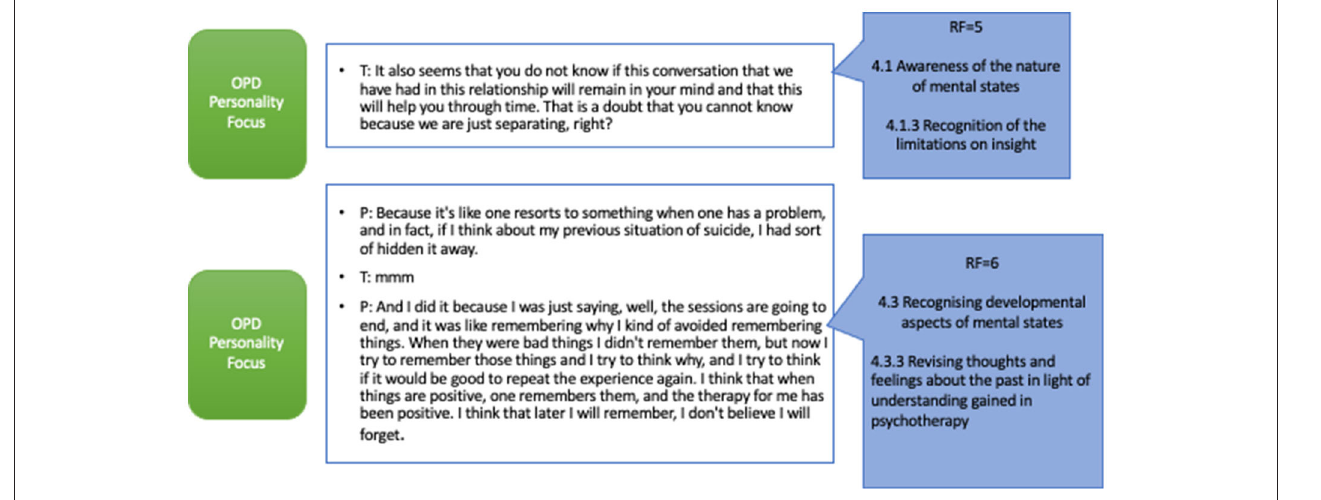
FIGURE 4 | Mentalizing interaction in personality focus